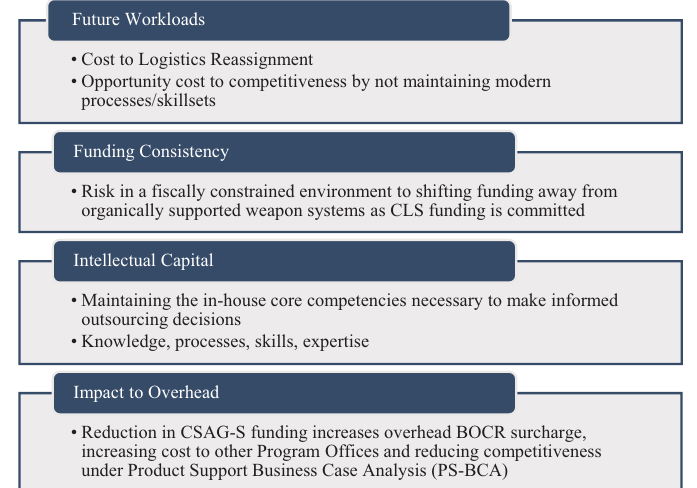
Figure 3. SCEG feedback